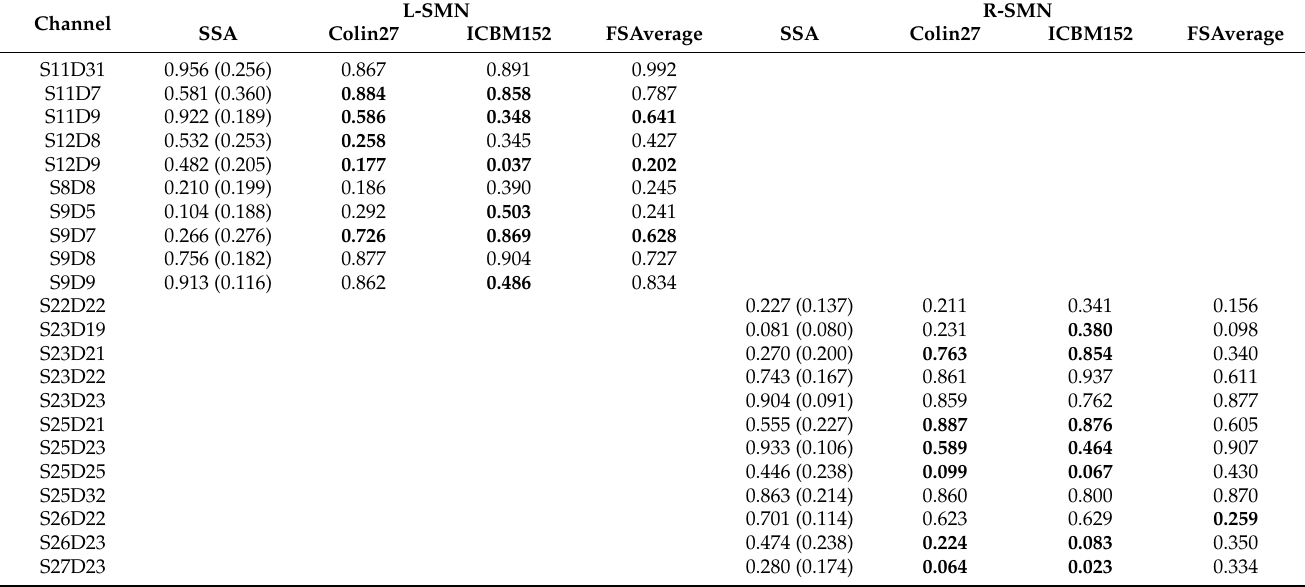
Table 10. Summary of A2Ch coefficients associated to selected functional ROIs associated to sensori- motor network (SMN). Results are reported for wavelength λ = 760 nm. Bold ABA values indicate channels presenting a 20% difference in A2Ch coefficients from the SSA